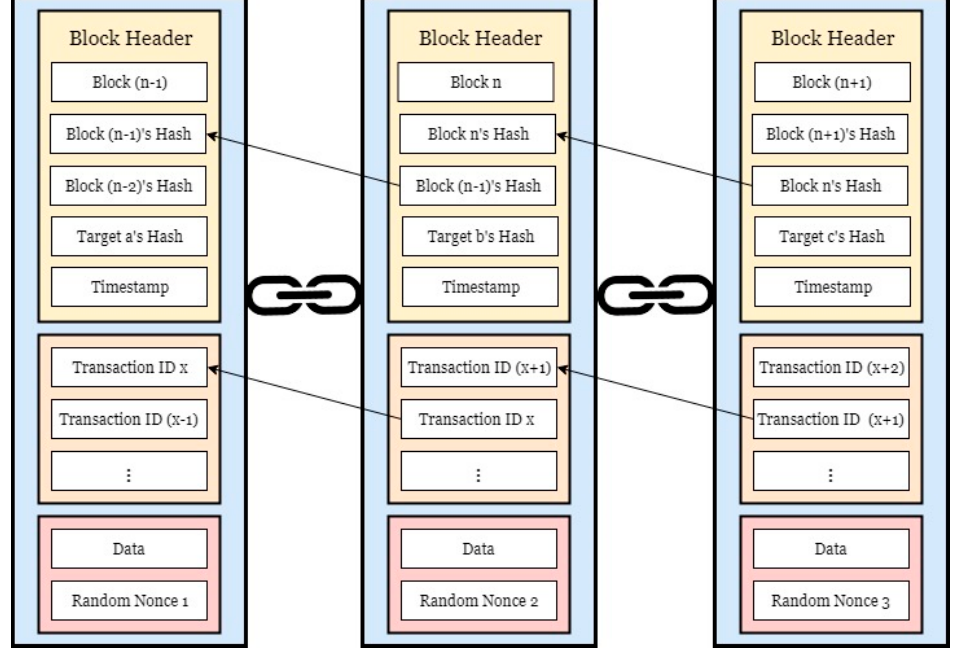
Figure 1. A conceptual look at a blockchain .